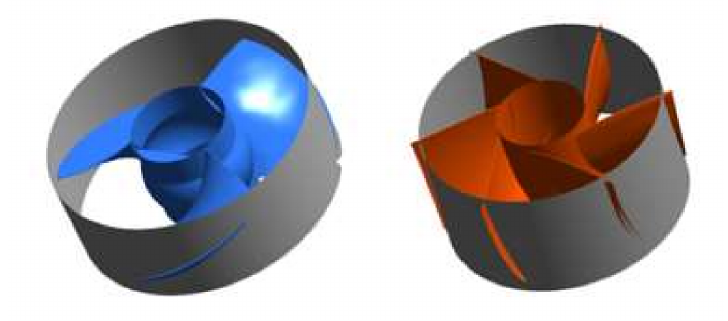
Figure 13. Cylinder section of impeller and guide